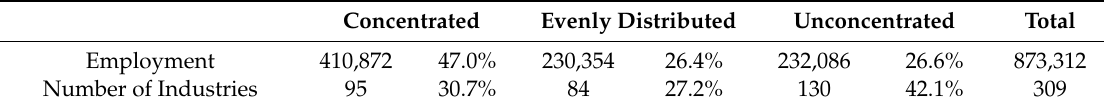
Table 3. Relative Concentration of Latinx